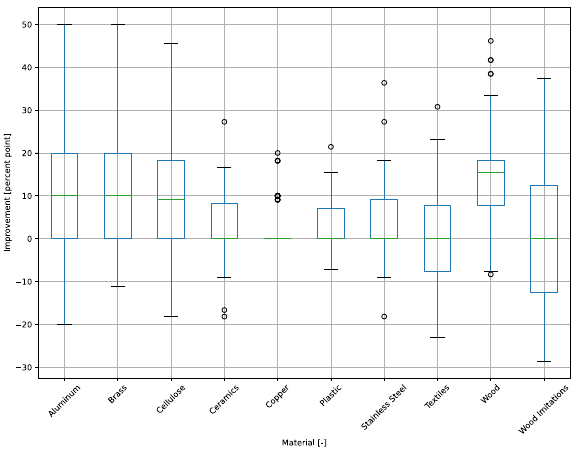
Figure 7. Boxplots of the material specific improvement when using IR features for ten times in a tenfold cross